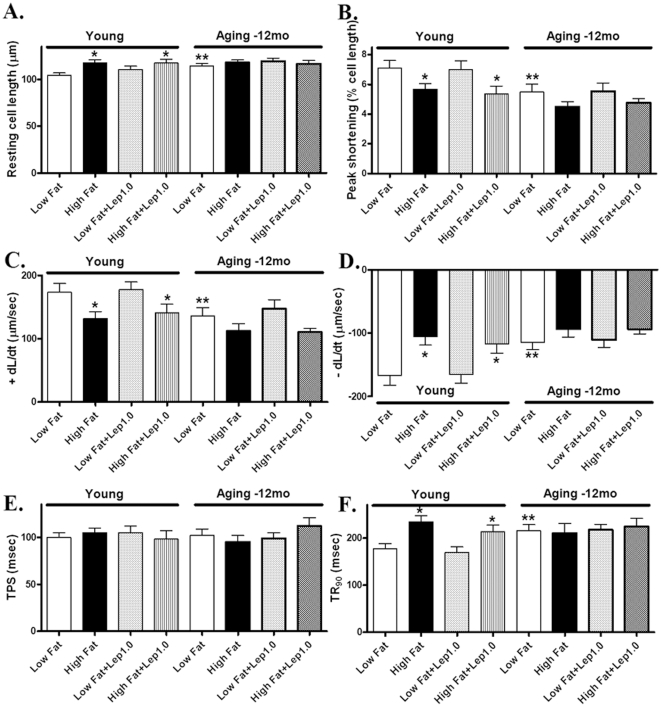
Contractile properties of cardiomyocytes isolated from young
(4-month-old) and aging (12-month-old) male C57 mice fed a low
(10%) or high (45%) fat diet for 16 weeks.Cohorts of cardiomyocytes were treated with or without leptin (1.0 nM)
for 4 hrs prior to mechanical study. A: Resting cell length; B: Peak
shortening (PS, normalized to cell length); C: Maximal velocity of
shortening (+ dL/dt); D: Maximal velocity of relengthening (-
dL/dt); E: Time-to-peak shortening (TPS); F: Time-to-90%
relengthening (TR90); Mean ± SEM,
n = 50–51 cells from 3 mice
per group, * p<0.05 vs. respective low
fat group, ** p<0.05 vs. young
low fat group.